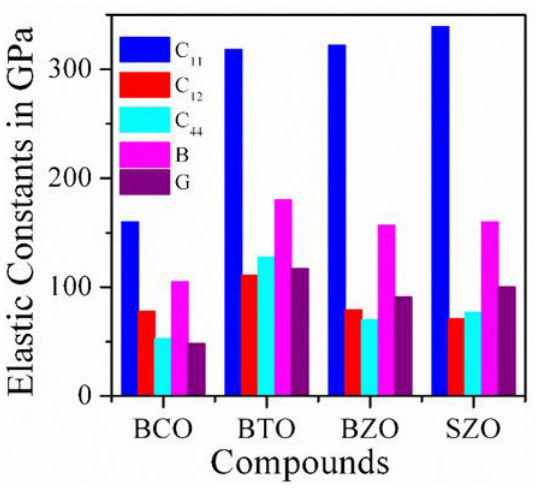
Figure 13. Comparison of different elastic moduli of BaCuO 3 with other perovskites.